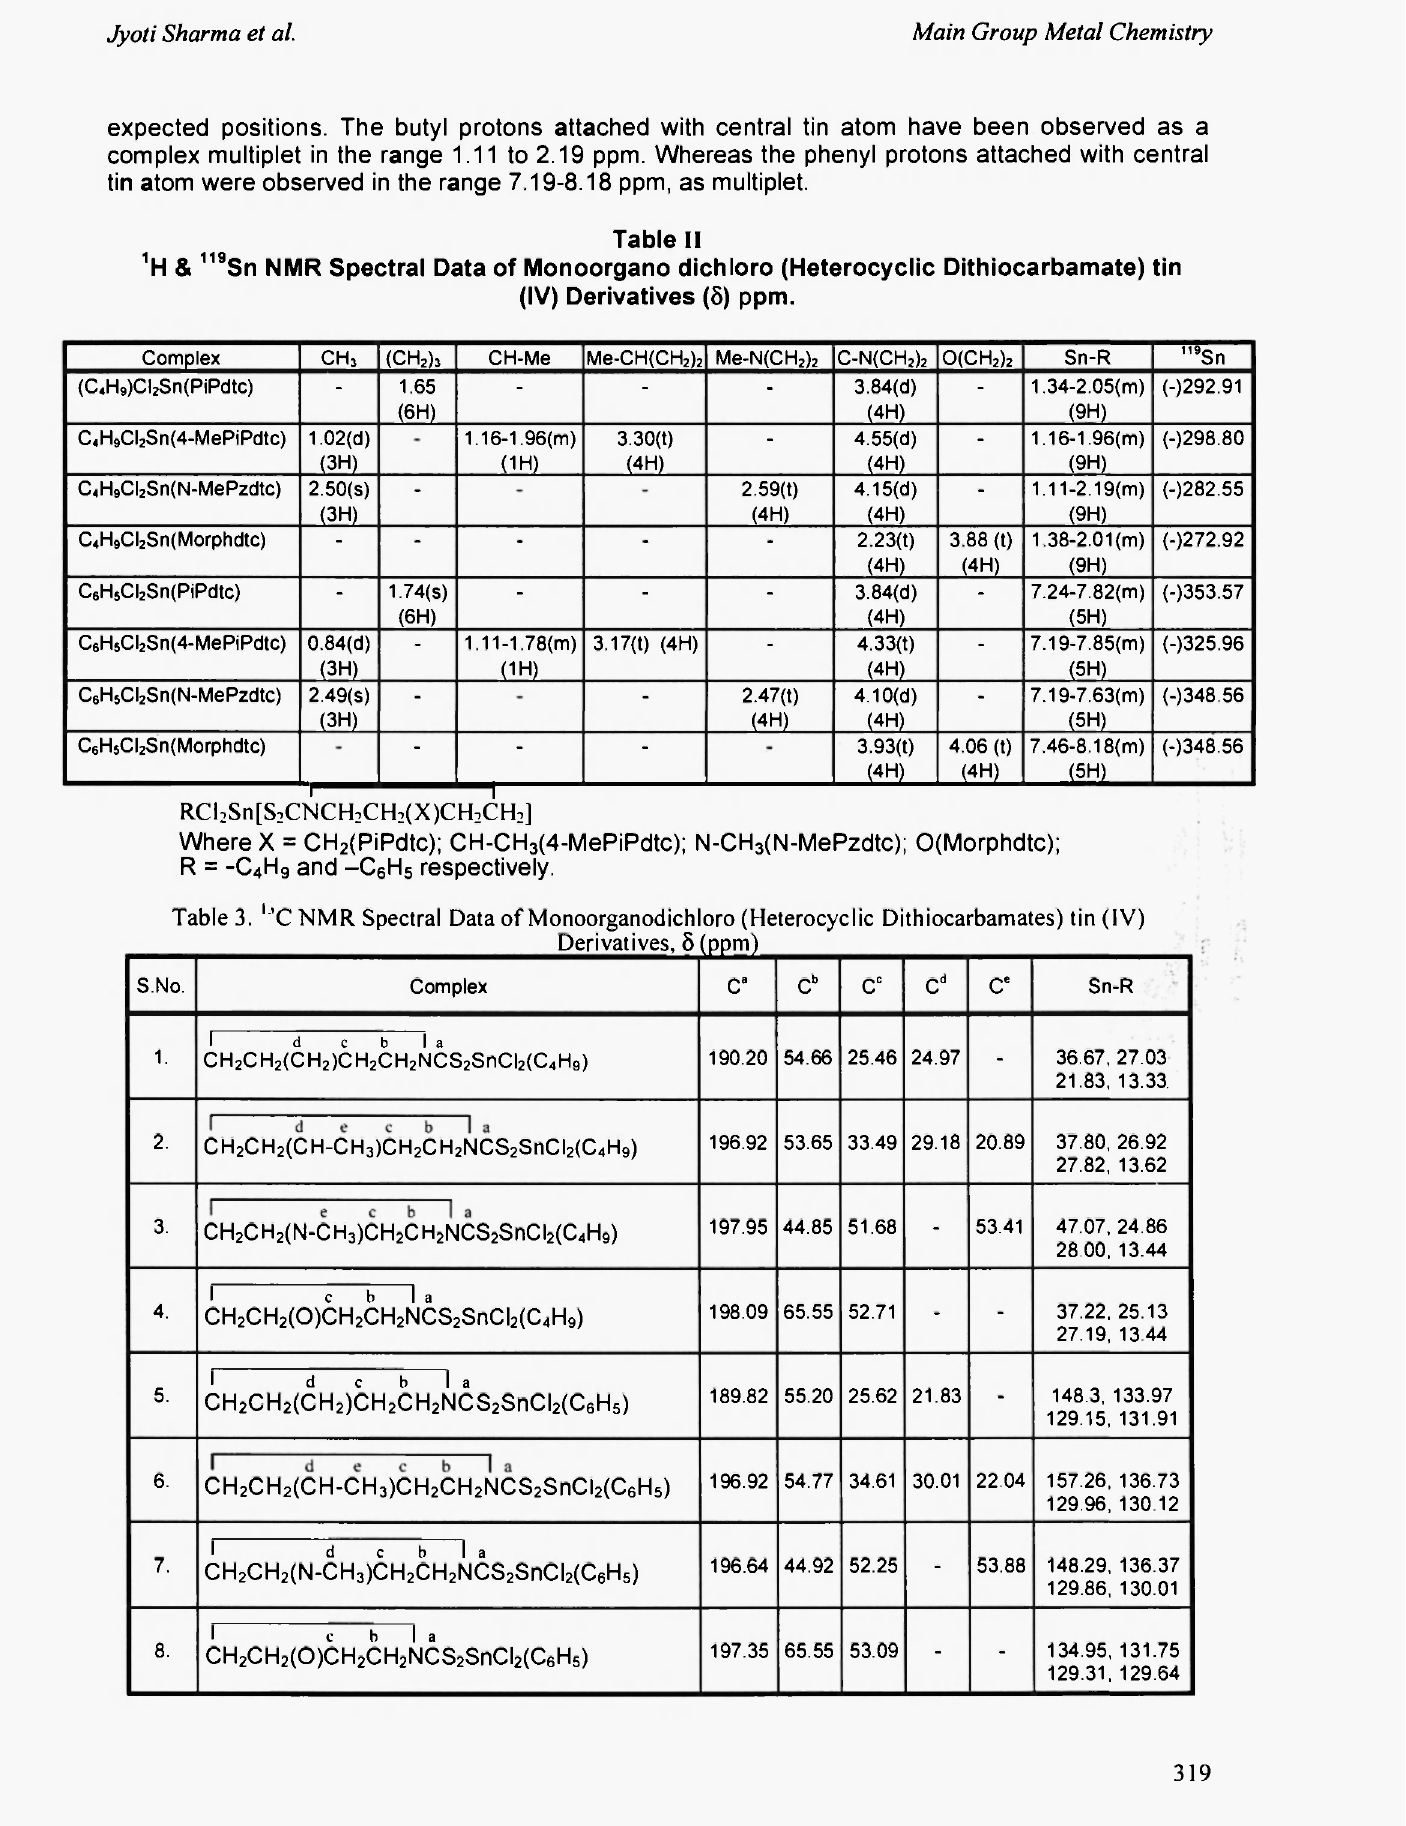
Table 3. lj C NMR Spectral Data of Monoorganodichloro (Heterocyclic Dithiocarbamates) tin